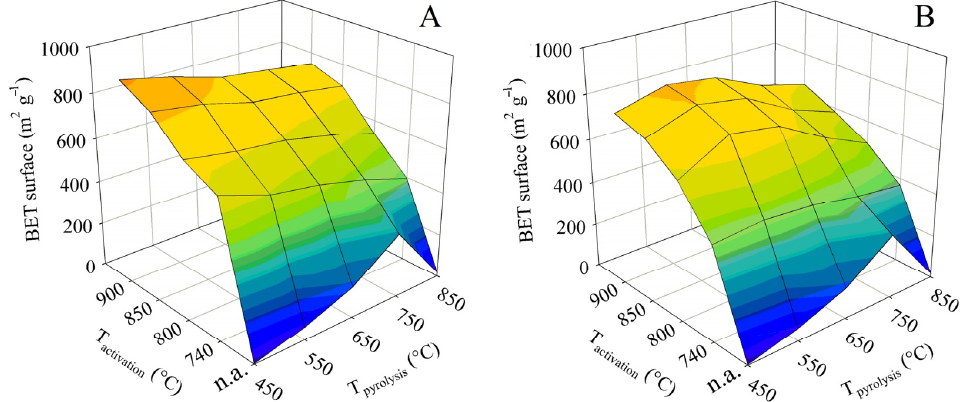
Figure 3. Changes in specific surface in dependence on pyrolysis and activation conditions for series ( A , B ).